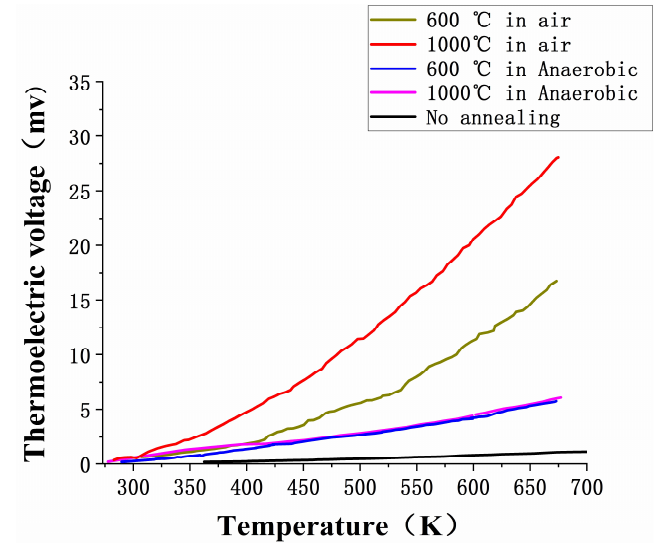
Figure 10. Thermoelectric voltage output of TFTCs.